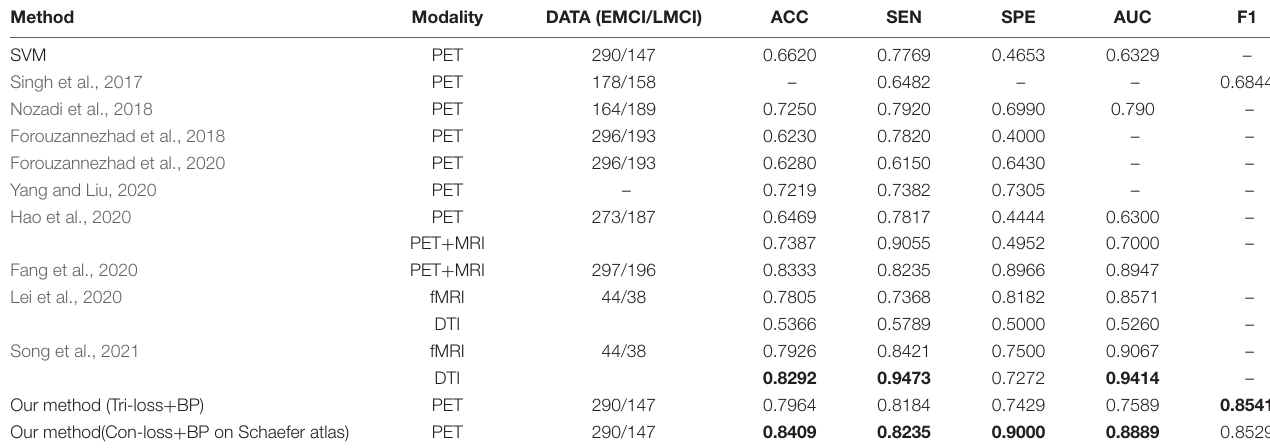
TABLE 7 | Comparison of the performance of different model algorithms in experiments for EMCI vs. LMCI classification with the related works. Method